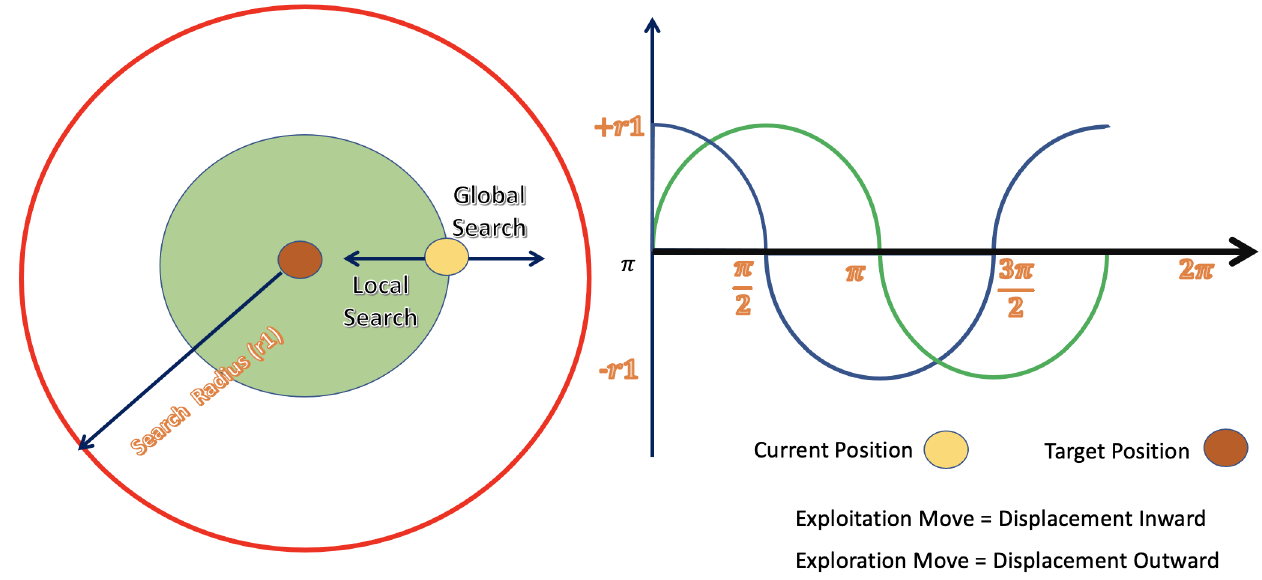
Figure 4. The process of the sine cosine optimization